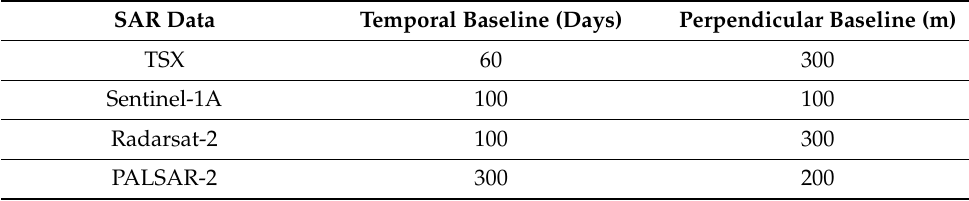
Figure A2. The examples of the weather condition on three TSX acquisition dates i.e., 20150729, 20150820, and 20160201. Table A1. The threshold of spatiotemporal baseline for each SAR data processing.